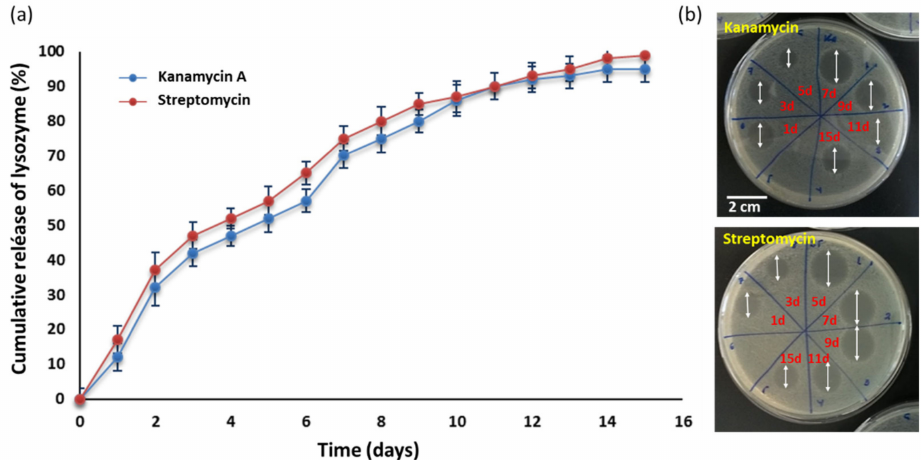
Figure 8. ( a ) In vitro release of kanamycin and streptomycin from the Ch/TPP/Alg microspheres. The mean cumulative concentration of antibiotic was expressed as a function of immersion